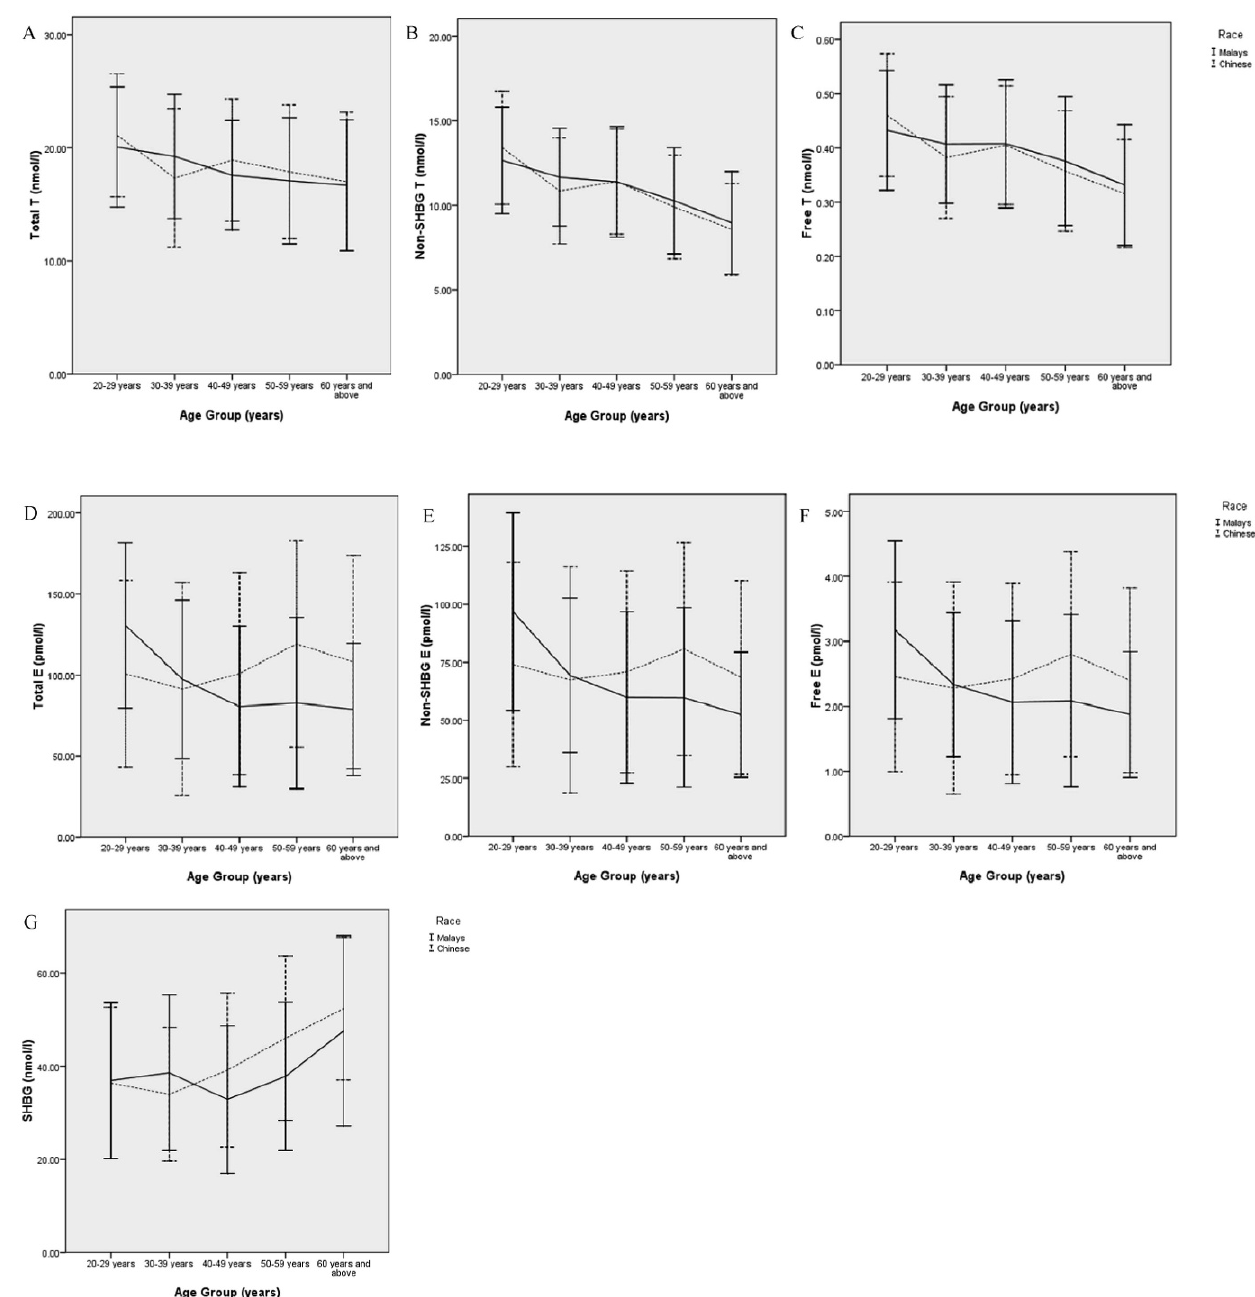
in Tables (3 & 4). Abbr : SHBG=sex hormone binding globulin; T=testosterone; Free T=free testosterone; Non-SHBG T=non-SHBG- bound testosterone; E=estradiol; Free E=free estradiol; Non-SHBG E=